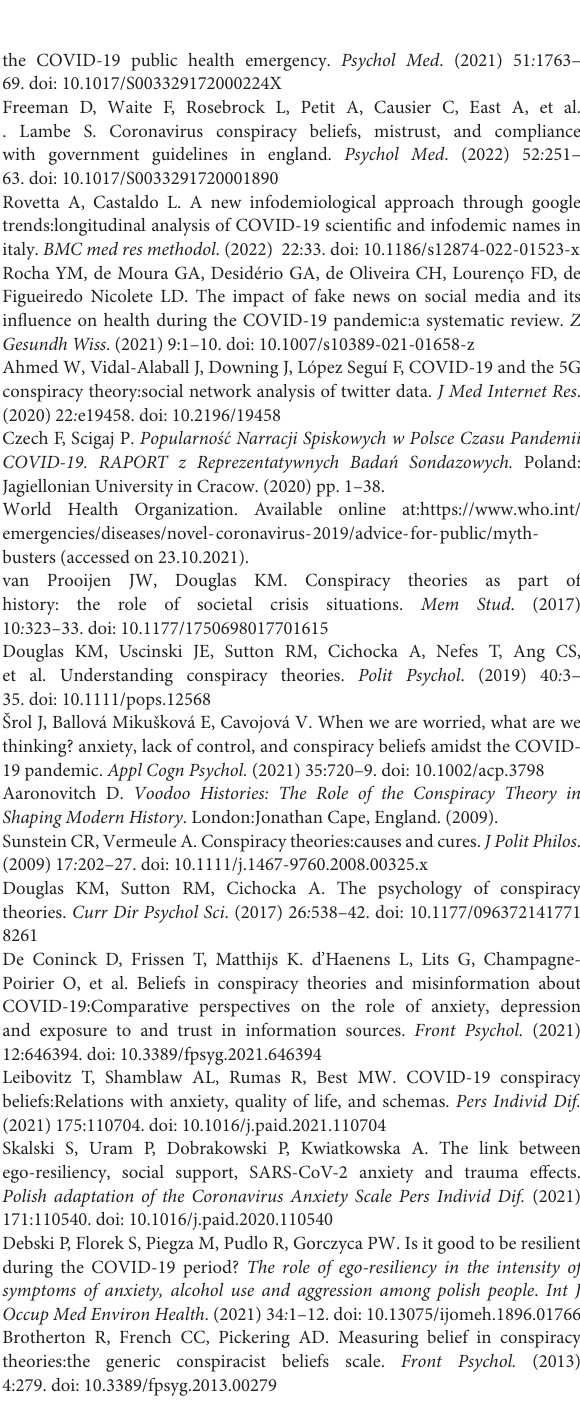
Supplementary Table S1 | Characteristics of regression models and intergroup differences.